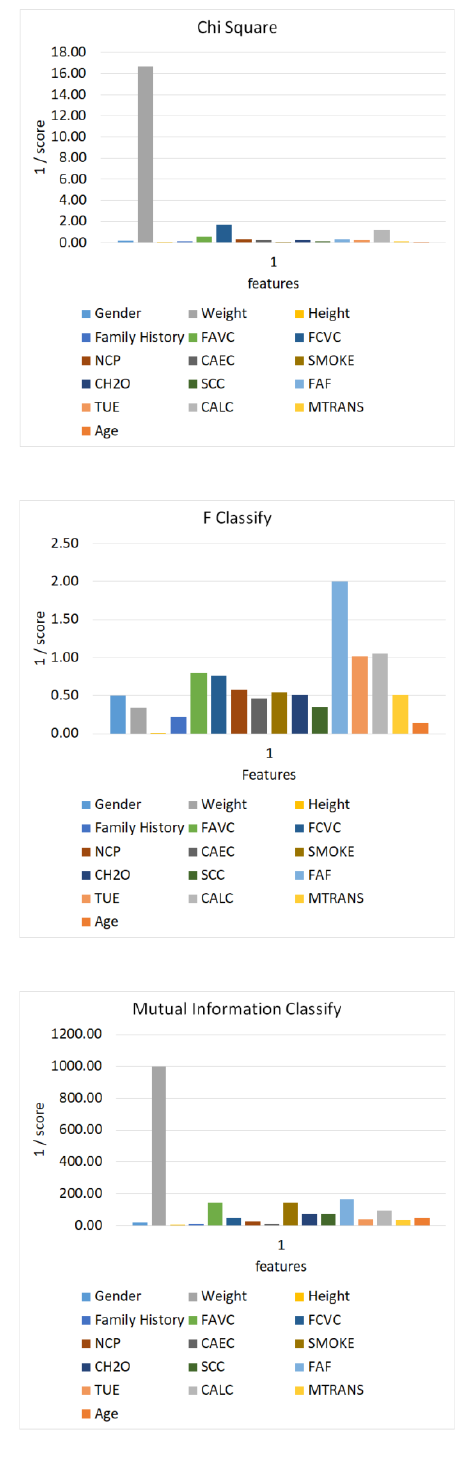
Figure 2. Bar chart of feature class determination scores. Each chart shows the importance of features in the data in the corresponding feature selection algorithm.